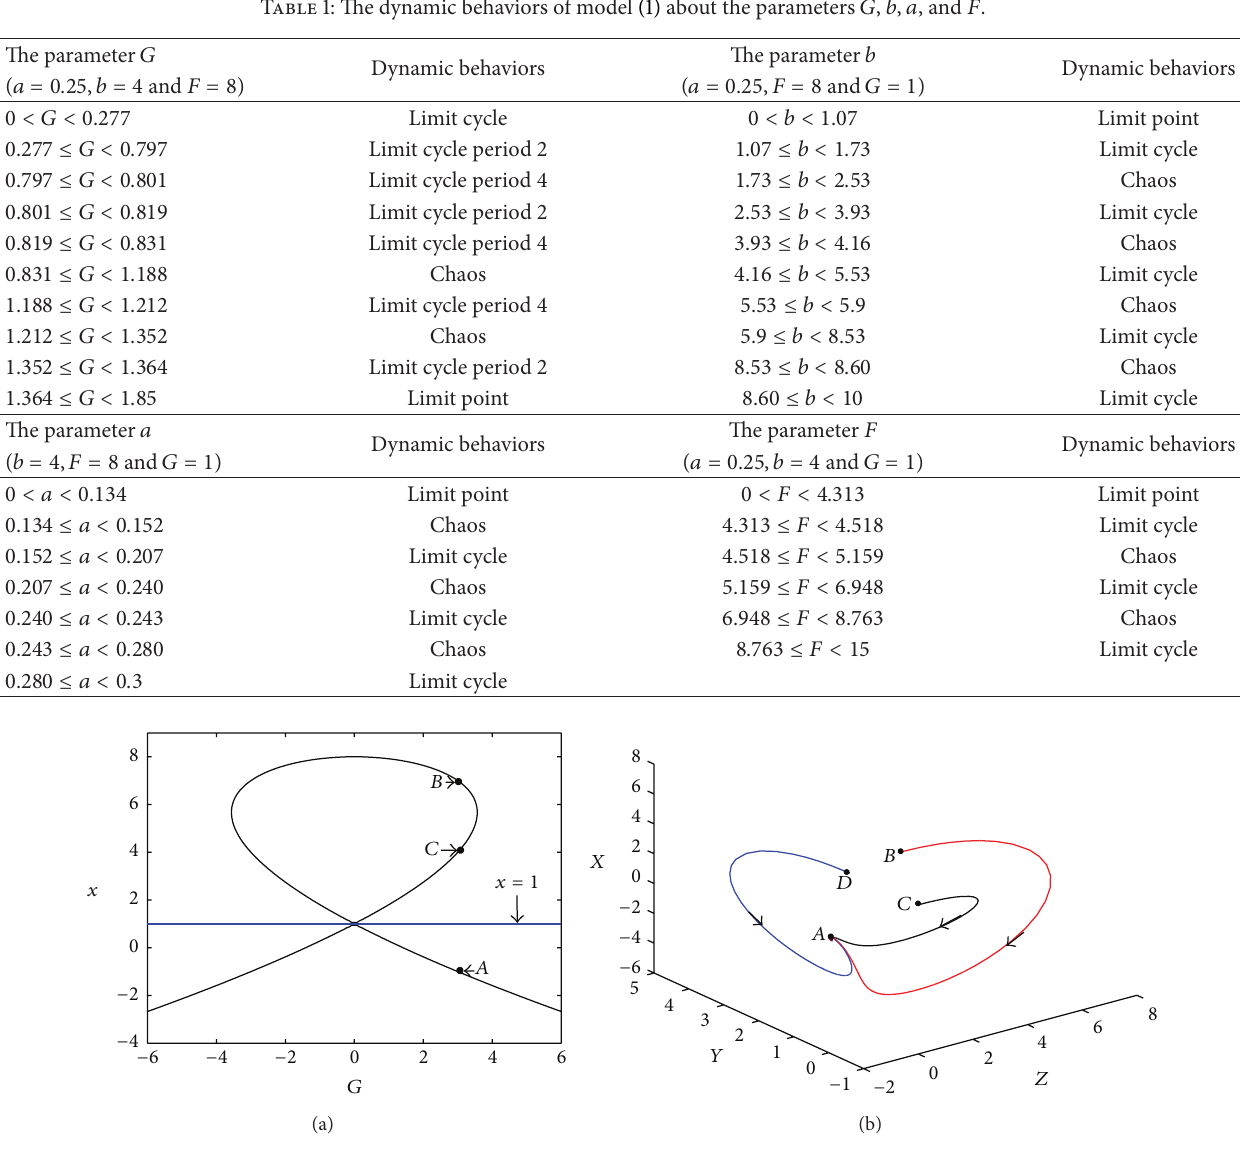
Figure 1: (a) The curve of 𝑎(𝐹 − 𝑥)(1 − 𝑥) 2 = 𝐺 2 . (b) Phase plane of system (1) with the parameter 𝐺 = 3